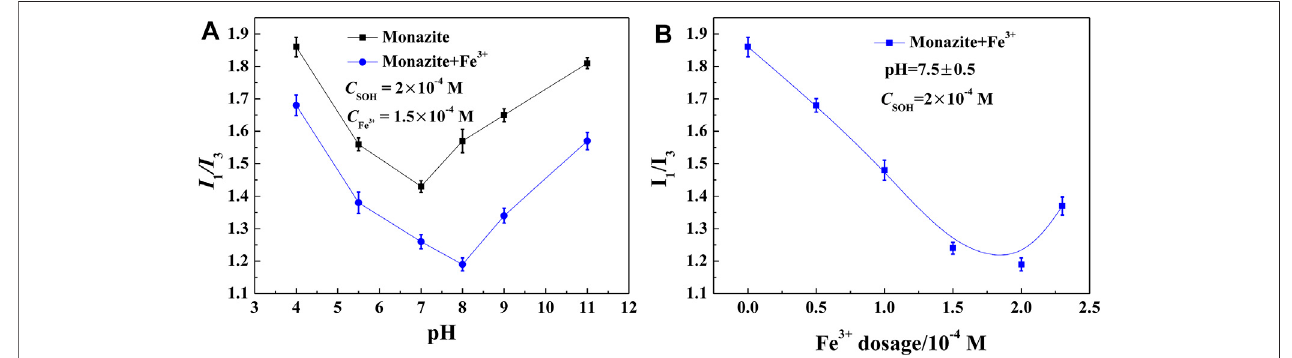
Frontiers in Chemistry |